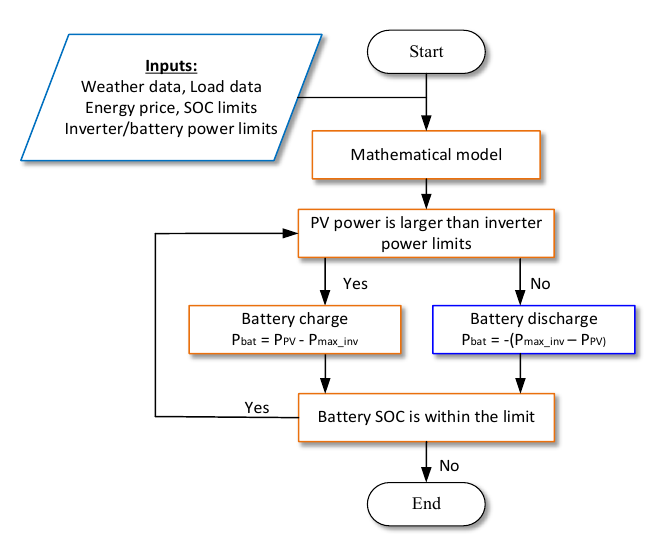
Figure 12. Flowchart of fully fed to grid strategy.